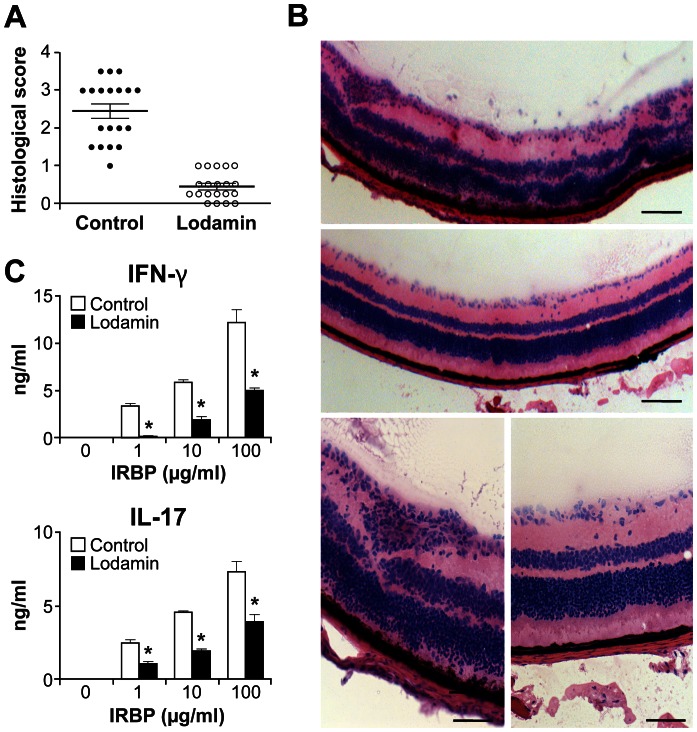
Oral administration of Lodamin reduces the severity of EAU with reduced antigen-specific Th1/Th17 reaction.(A) histological score of EAU evaluated on day 21 post immunization with IRBP1–20- in response for oral Lodamin treatment (30 mg/kg q.o.d) (○) or vehicle (•) (n = 20, mean ± SEM, *p<0.05 Mann-Whitney U test). (B) represented histopathological images of eyes enucleated from vehicle (control) or Lodamin-treated mice on day 21 post IRBP1–20 immunization. The control mice exhibited uveitis with focal loss of the photoreceptor layer in the choroid as well as massive infiltrates of monocytes in the retina, vitreous, and choroid with retinal folding and focal granulomatous lesions (arrows). In contrast, in Lodamin treated group only a few inflammatory cells are observed. Scale bars = 100 µm. (C) FACS analysis of IFN-γ and IL-17 production by T cells from draining lymph node. CD4+ T cells from Lodamin-treated mice produced significantly less IRBP-specific IL-17 as well as IFN-γ than cells from untreated mice on day 21 post after IRBP1–20 immunization (mean ± SEM, n = 3, *p<0.05).